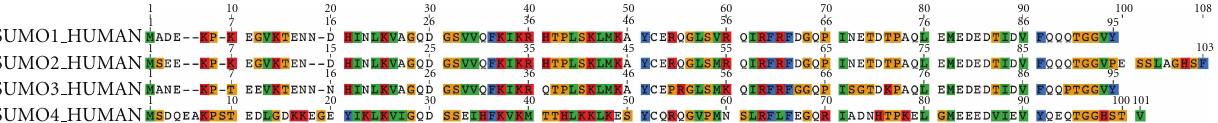
Figure 1: Sequence alignment of Homo sapiens SUMO-1 to SUMO-4. UNIPROT sequences shown are SUMO1 (P63165), SUMO2 (P61956), SUMO3 (P55854), and SUMO4 (Q6EEV6). The alignment is CLUSTAL colored using the software Geneious v4.8.5 (available from http://www.geneious.com/).